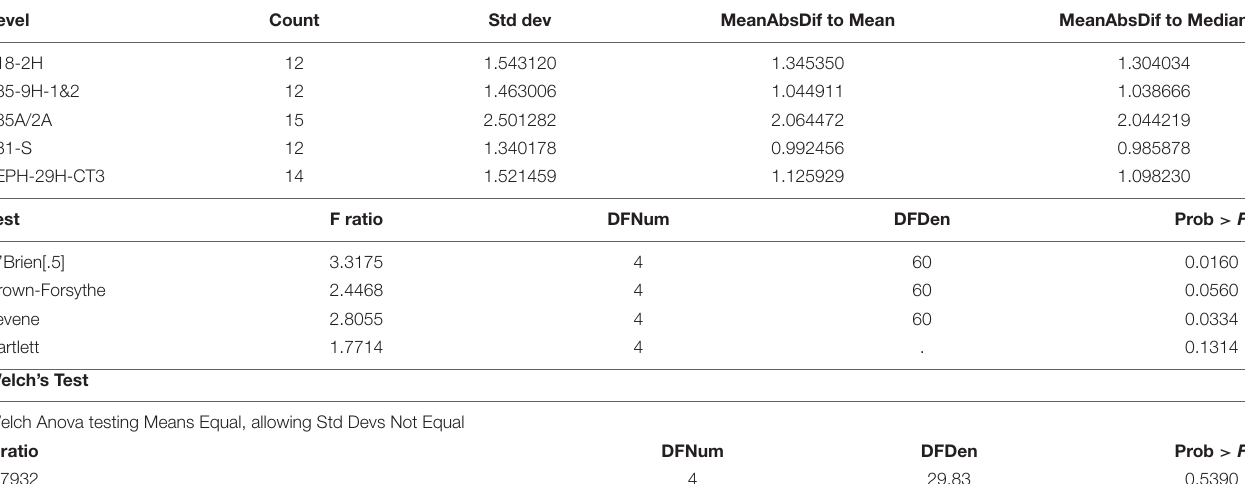
TABLE 1 | Cooling tower water Legionella pneumophila concentration